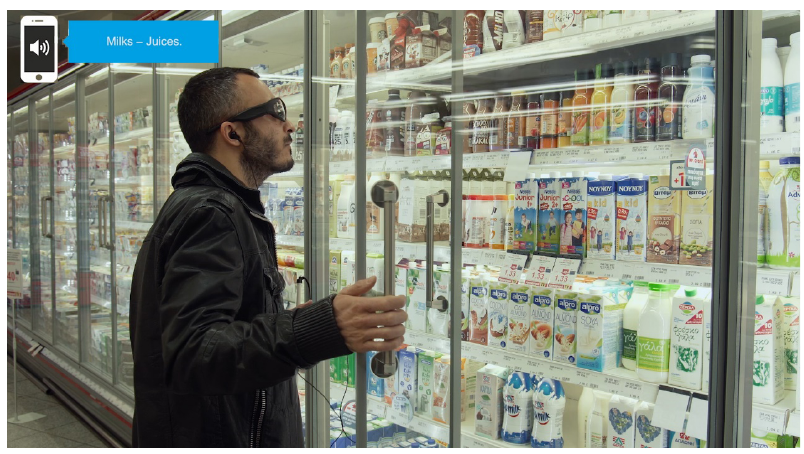
FIG. 8 Usage of the e-Vision application during an actual supermarket visit by a visually impaired person. The blue textbox contains the message being communicated to the